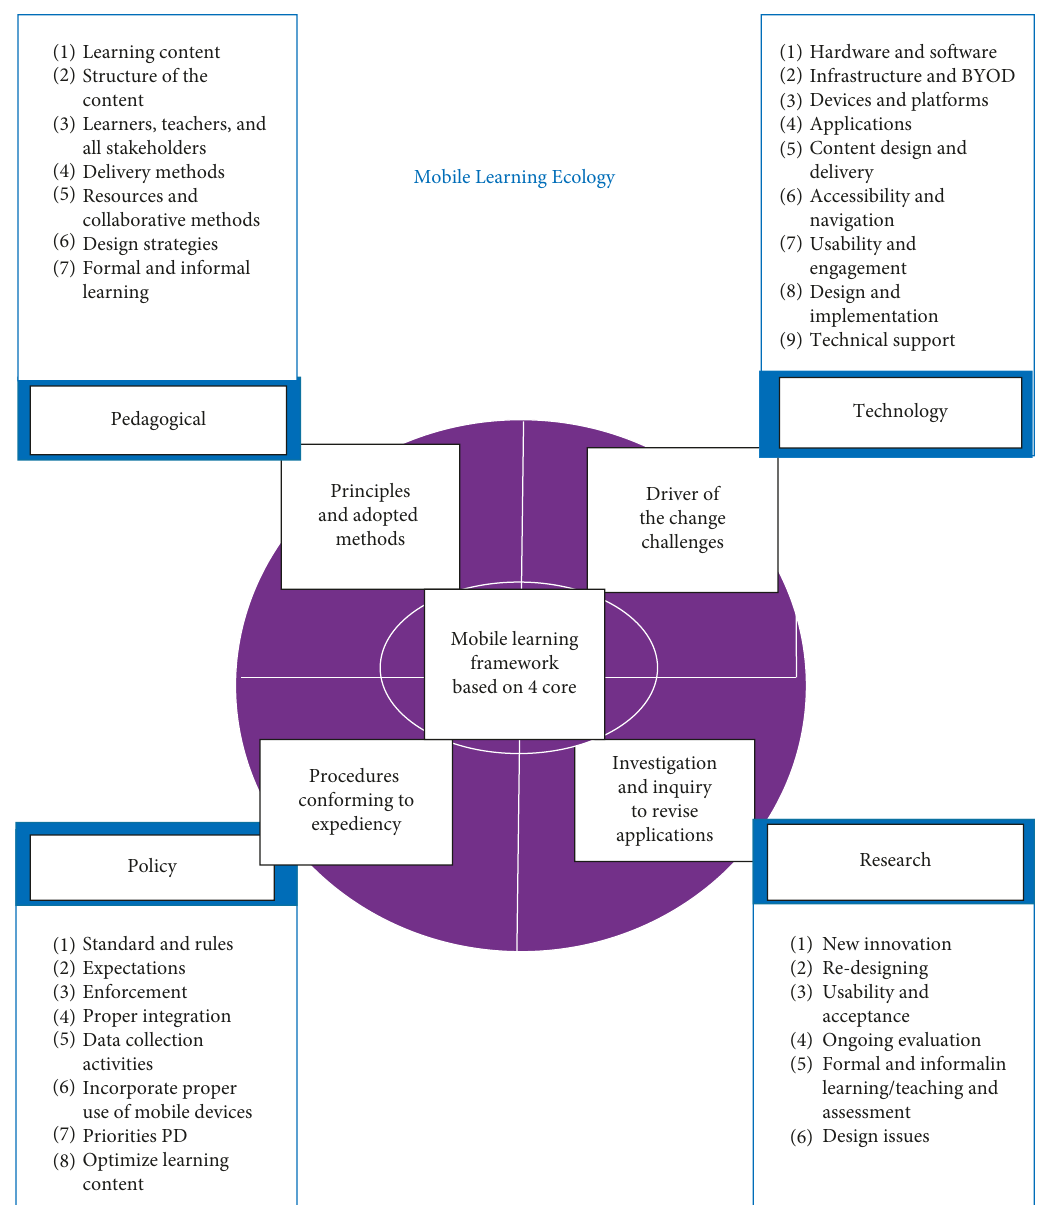
Figure 11: A framework for mobile learning based on 4 core